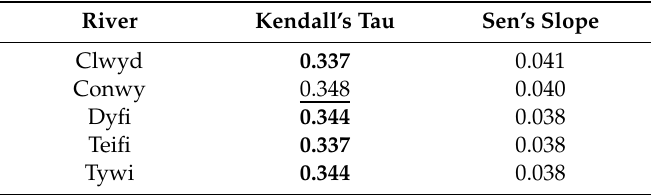
Table 3. Pettitt and SNHT method breakpoint analysis statistics for shown stepped increase in annual average autumn temperatures since 1994 in all study catchments.